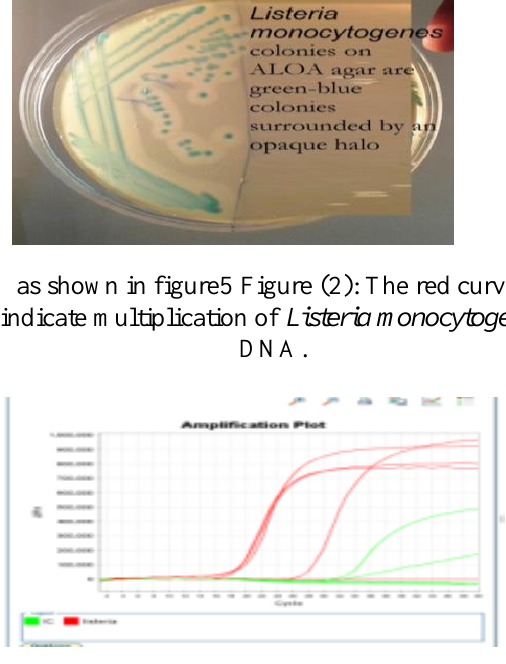
Figure (3): The Multicomponent Plot using FAM (reporter) pigment to authenticate the results obtained in figure 2.